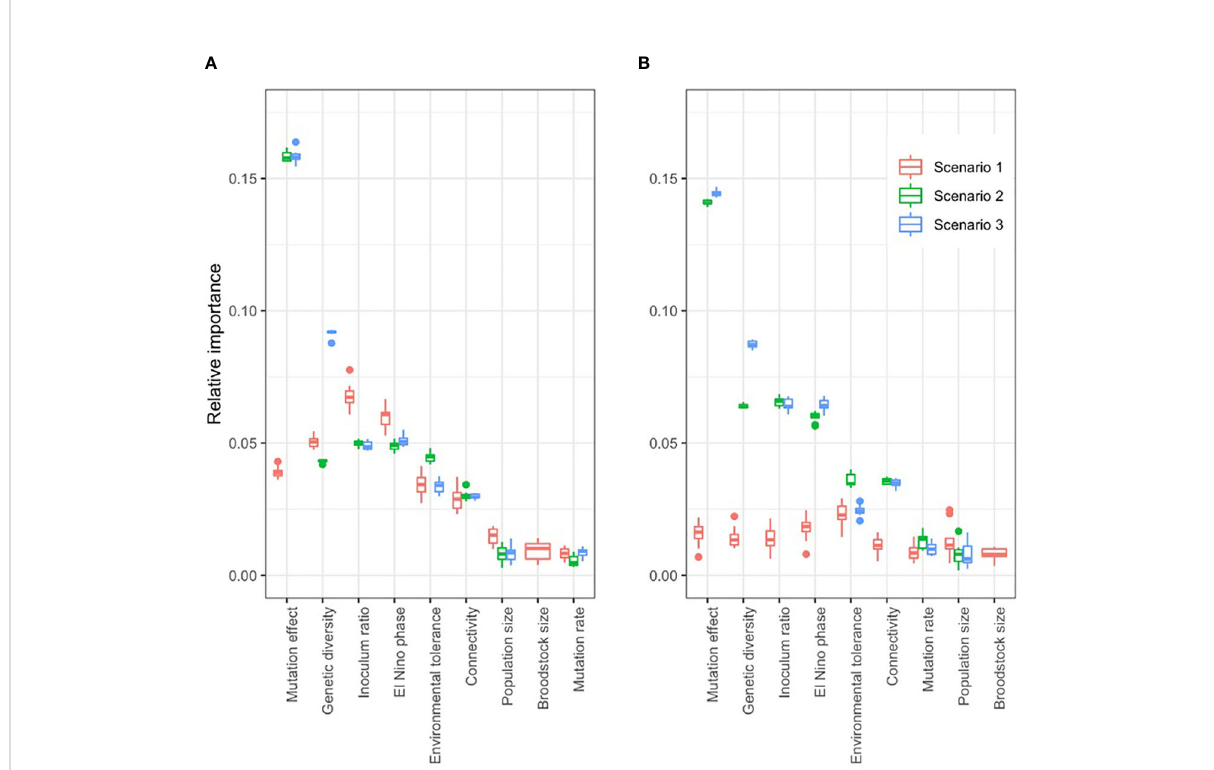
FIGURE 5 Relative importance of model parameters on the fi tness effect of three intervention types: reproductively crossing extreme warm and cold populations (scenario 1), reshuf fl ing the standing genetic variation arti fi cially (scenario 2), or adding novel genetic variation (scenario 3). Relative importance was measured by the standard deviation of fi tness effect, varying the target parameter while keeping the others constant. When the target population lies in the middle of the environmental gradient that exists along the range of the metapopulation (B) , Scenario 1 (crossing warm and cold populations) has negligible fi tness effect; while the same intervention in a colder population yields fi tness effect (A) . Boxplots show the results of ten independent simulations for each parameter